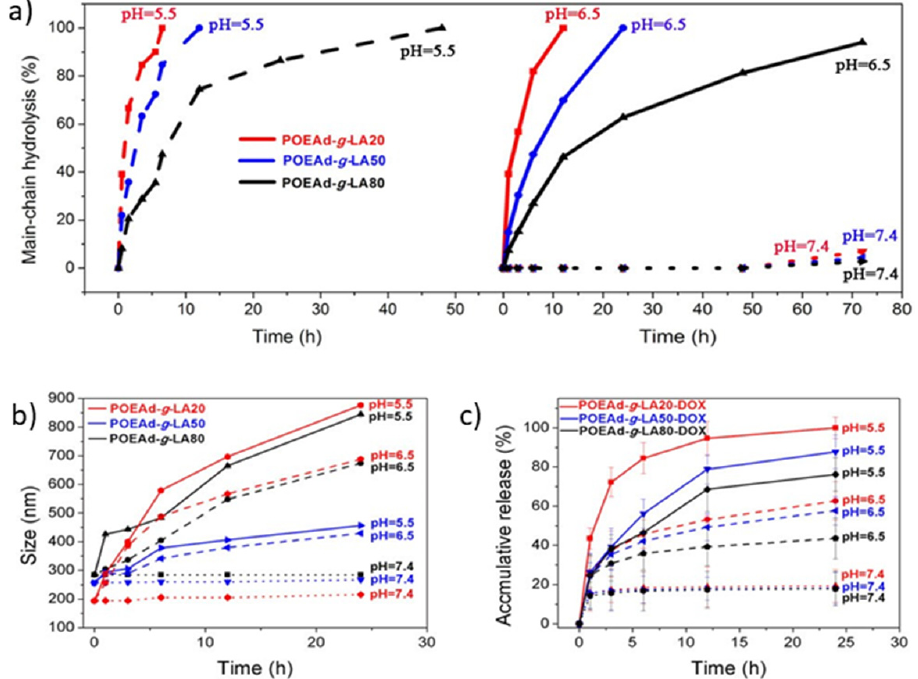
Figure 2. ( a ) Hydrolysis kinetics of POEAd‑g‑LA micelles at pH 7.4, 6.5 and 5.5; ( b ) Time and pH‑ dependent changes of average size of POEAd‑g‑LA micelles in aqueous phosphate buffer measured by DLS; ( c ) Release kinetics of loaded DOX in POEAd‑g‑LA micelles at pH 7.4, 6.5, and 5.5 (Reprinted with permission from Ref. [61]. 2017, Guoqing Yan).